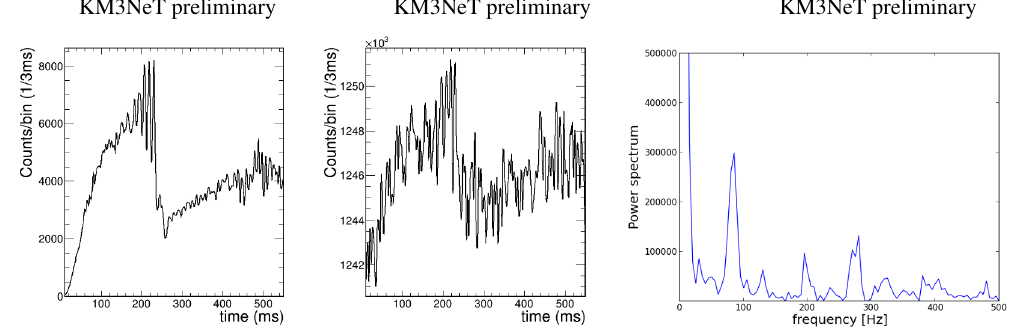
Figure 4. On the left, the expected light-curve for CCSN at 5kpc, where SASI oscillations are seen at around 200 ms. On the middle, the expected light-curve in one KM3NeT block when adding background. On the right, the power spectrum for background + signal at 5 kpc, where the peak is recovered at the SASI oscillation frequency. The detected CCSN neutrino light-curve has been simulated for a the 27 M (cid:12) progenitor at